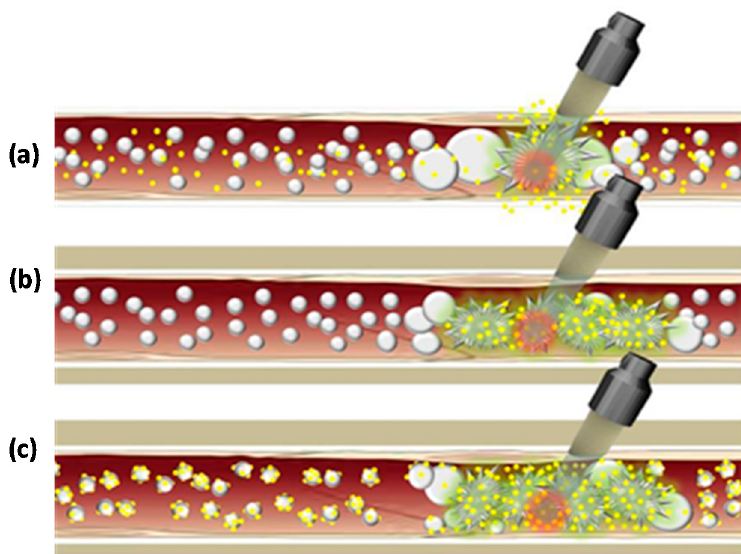
Figure 7. Schematic of different ways of drug delivery utilizing microbubbles. ( a ) Free drug particles (yellow circles) are circulated along with ultrasound microbubbles (grey circles) in vessels, and the effect of ultrasound on growth and burst of microbubbles results in extravasation of drug into adjacent soft tissues. ( b ) Drugs encapsulated inside microbubbles are circulated in the vasculature and microbubbles are ruptured by ultrasound and the transported substances are released into the surrounding targeted tissue. ( c ) Drugs loaded on the external membrane of microbubbles, freely circulated in vessels and then ruptured by ultrasound with the drug being released into the target.